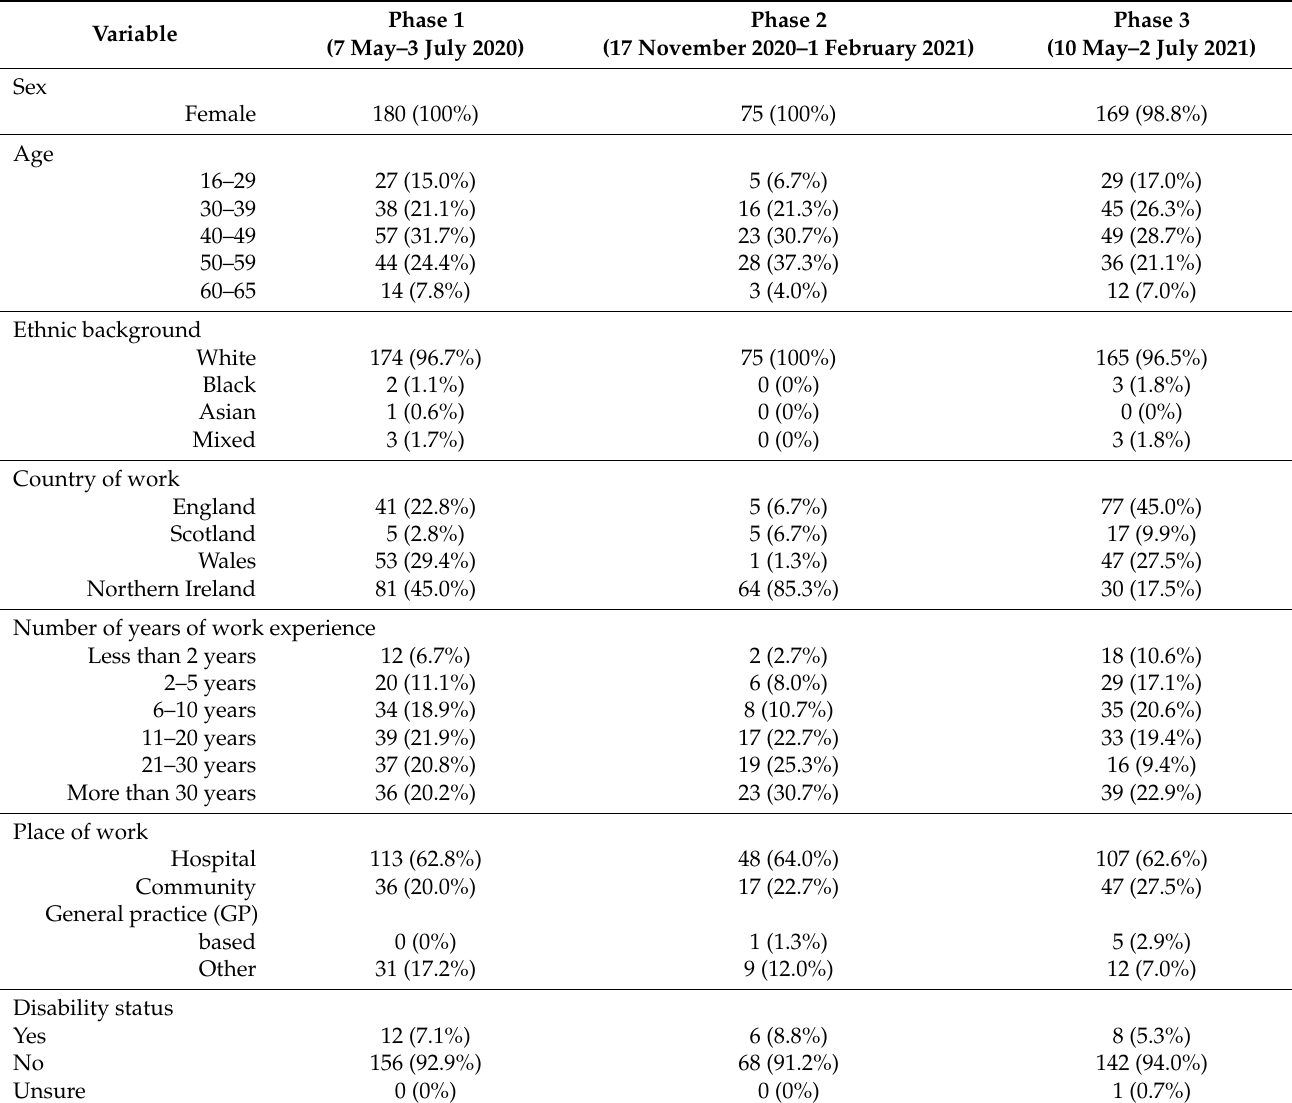
Table 1. Sociodemographic details of midwifery sample (N =